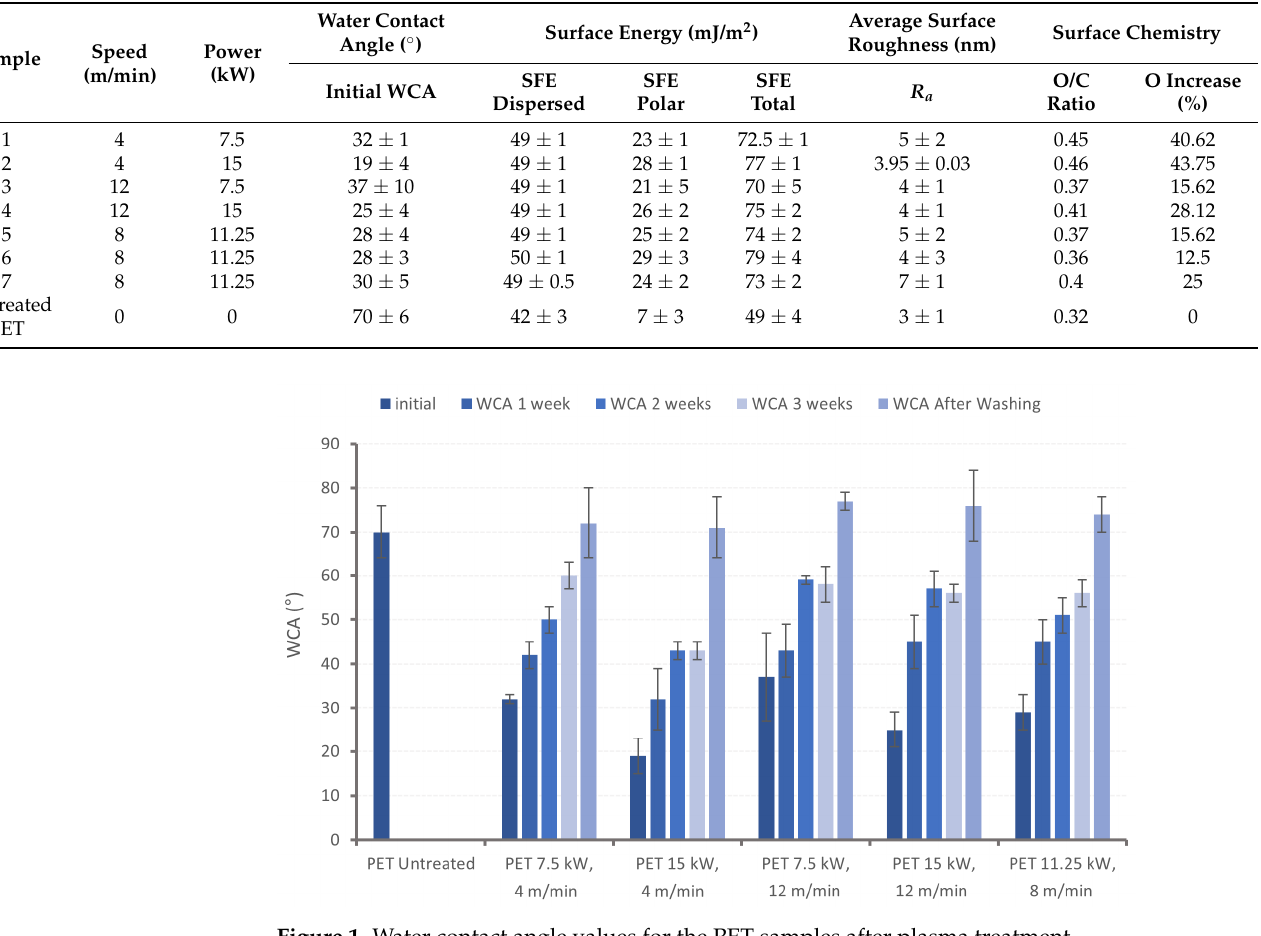
Table 2. Water contact angles, surface energy, average roughness and chemistry values found for the PET plasma-treated samples.